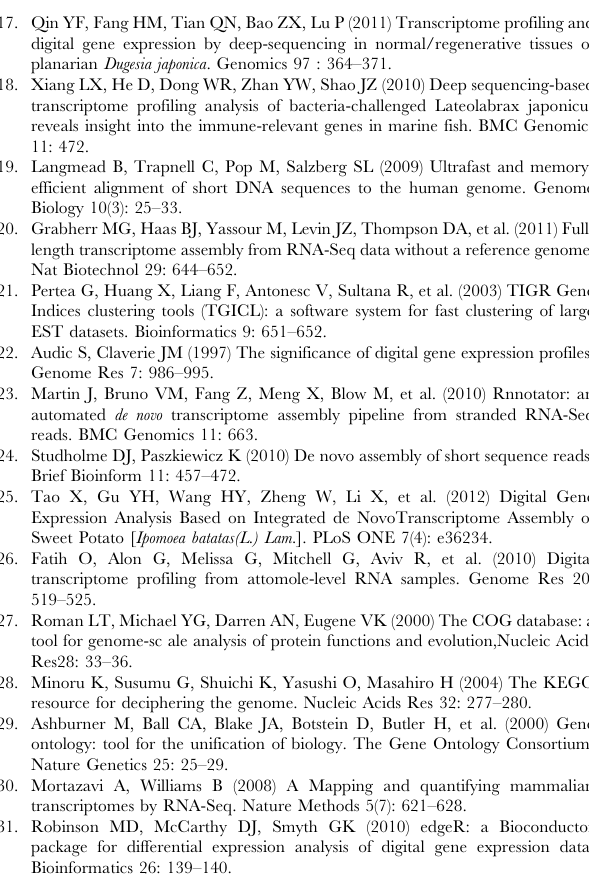
Table S1 Annotation for the unigenes. Table S2 The differentially expressed genes in the two libraries. Table S3 Significantly enriched GO terms in DEGs. Table S4 Pathway enrichment analysis of